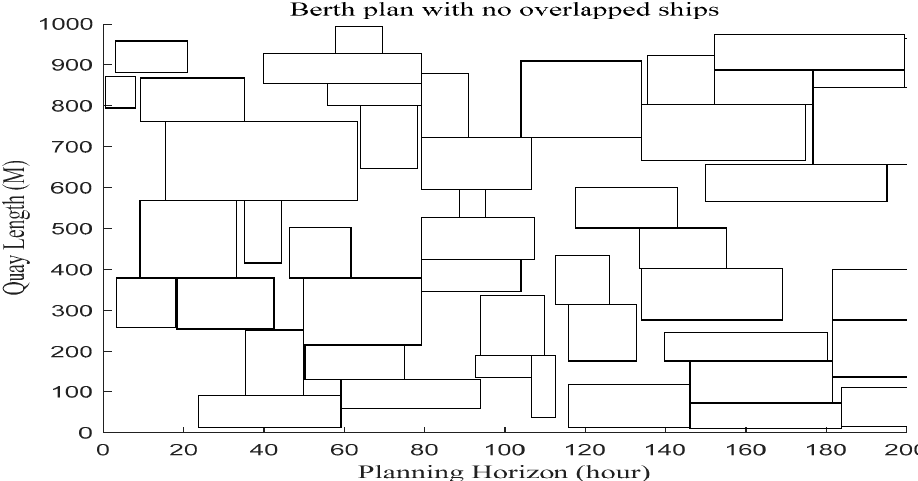
Figure 14. The feasible berth plan after resolving all overlaps of ships ( N = 50 ships).